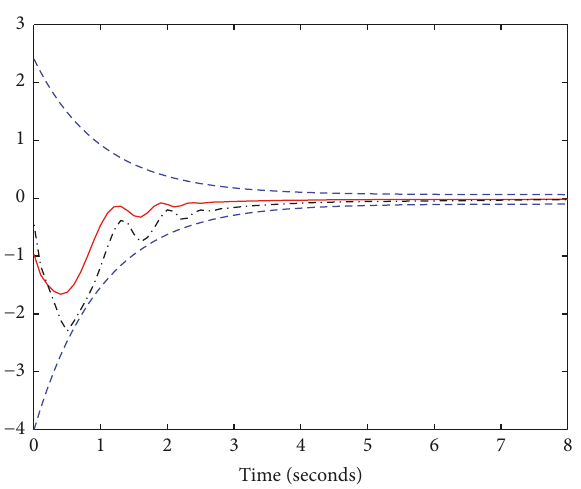
Figure 13: Angular velocity tracking error 𝑒 21 : neural learning control (—), ANC (- ⋅ - ⋅ ), and the error bounds (- - -).